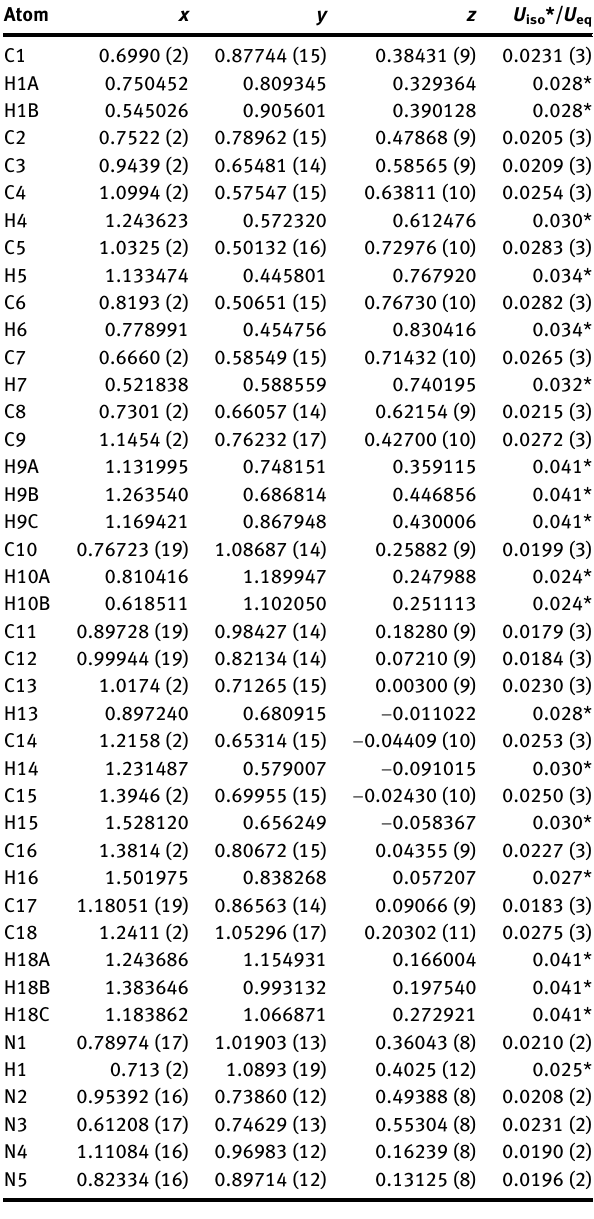
Table  : Fractional atomic coordinates and isotropic or equivalent isotropic displacement parameters (Å 